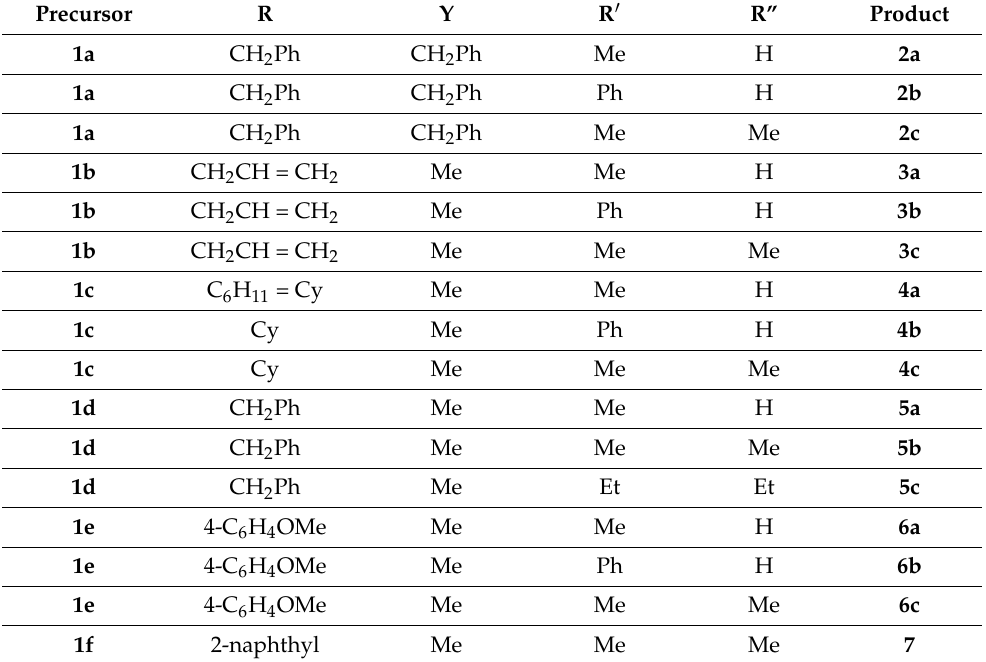
Table 2. Diiron vinyliminium complexes ( 2–7 ) obtained by aminocarbyne precursors ( 1a–f ) according to Scheme 17. Precursor R Y R (cid:48) R”